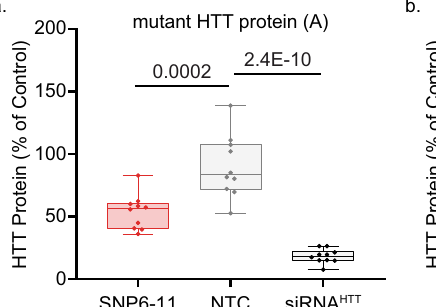
was used as a positive control. A non-targeting control (NTC) siRNA was used as a negative control. One-way ANOVA and posthoc Tukey test; n =10 biological repli- cates (wells) per group. Error bars extend to minimum and maximum value. The lowerboundoftheboxisthe25thpercentileandtheupperisthe75th,withalineat the median. Source data are provided as a source data fi